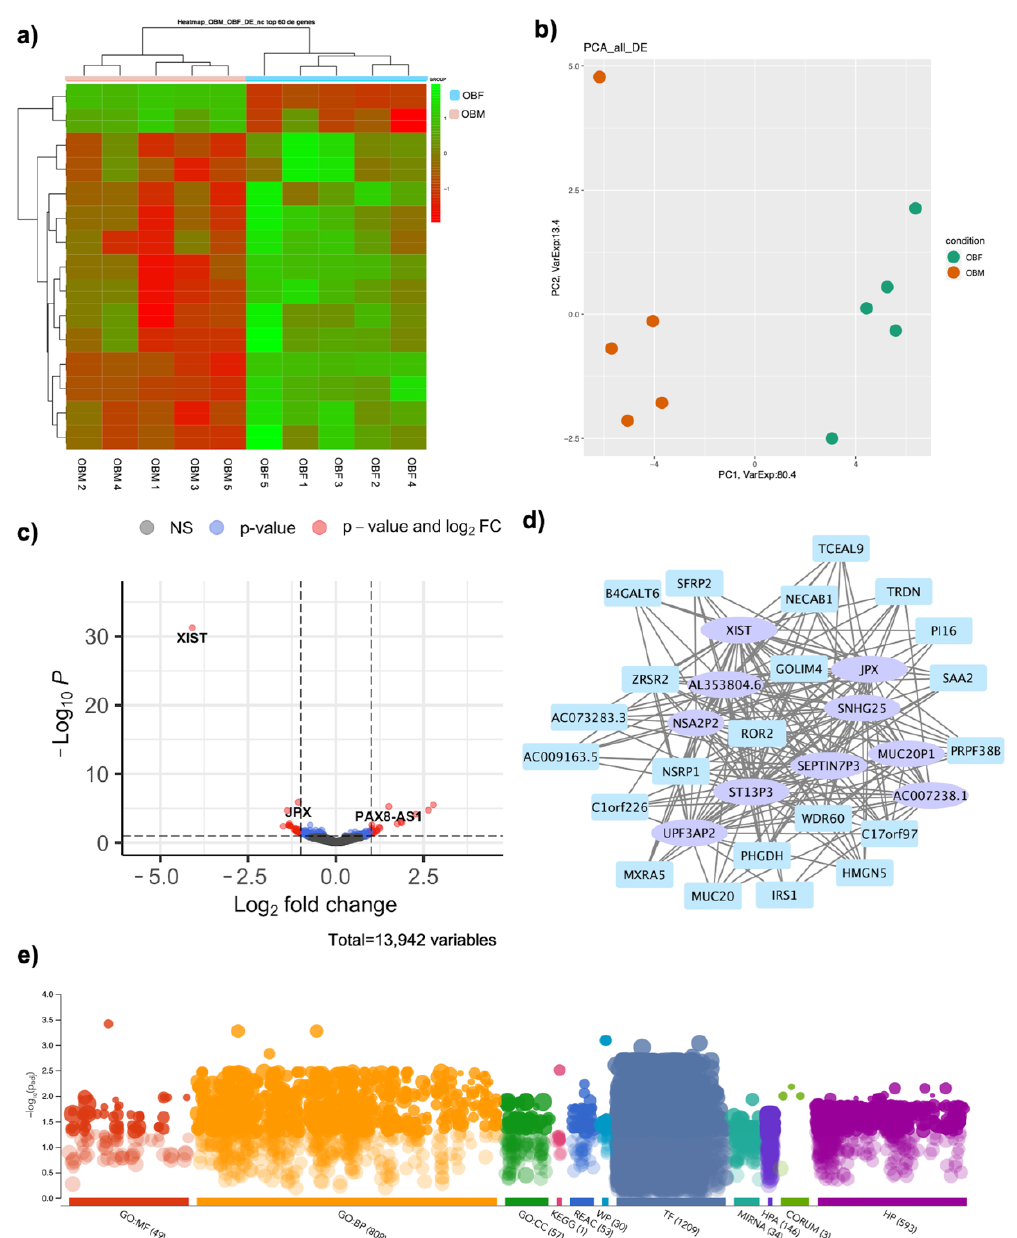
Figure 6. Implications for ncRNAs in DE RNAs in OBM vs OBF: ( a ) Heatmap analysis of nc DE RNAs in OBM versus OBF. ( b ) PCA of nc DE RNAs in OBM versus OBF. ( c ) Volcano plot showing nc DE RNAs between OBM and OBF. ( d ) WGCNA Co-interaction network between coding and ncRNAs. Coding genes are displayed as light blue rectangles whereas nc DE RNAs are represented as purple ellipses. ( e ) DE RNAs connected to nc DE RNAs were subjected to functional enrichment analysis via the g:Profiler web tool, ranking the genes in term of their absolute FC and considering a Bonferroni–Hochberg FDR of 0.05 as significance threshold. Significant terms were found in all categories analyzed, which include gene ontology (GO), with 49 significant pathways for molecular function (MF), 808 significant pathways for biological processes (BP), and 57 significant pathways for cellular component (CC) pathway analyses, which highlighted 1 significant pathways for KEGG, 53 significant pathways for Reactome, and 30 significant pathways for WikiPathways, along with 1209 regulatory motifs in DNA (TF), 34 genes targeted by miRNAs (MIRNA), protein expression (HPA, 146) implications for protein complexes with CORUM (3), and implications for human phenotypes (HP, 593).